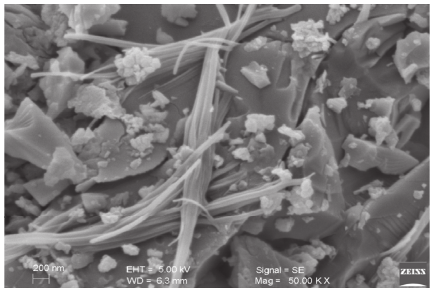
Figure 16: Scanning electron microscopy (SEM) of mix Table 3: Linear regression for the strength of concrete for all mix designs for 3, 7, 28, 60, and 90days for 5% of natural zeolite with varying percentages of metakaolin.